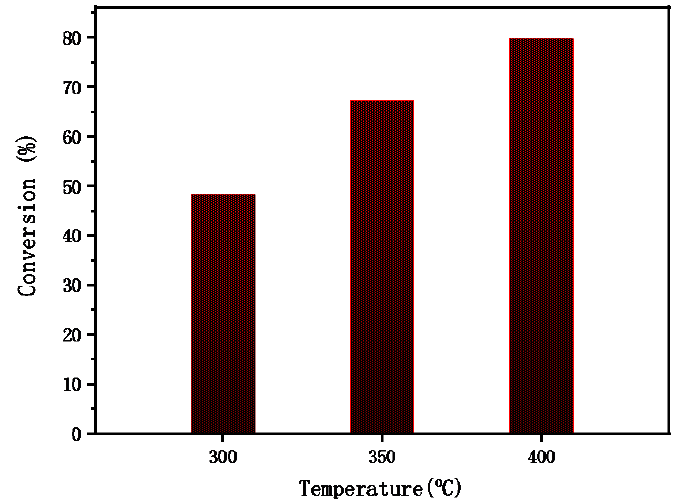
Figure 1. The conversion of n-decane at different temperatures over Z–100. The reaction conditions: Catalyst weight = 0.3 g, F C10 = 0.03 g/min, F gas = 20 mL/min, Pressure = 0.1 MPa.